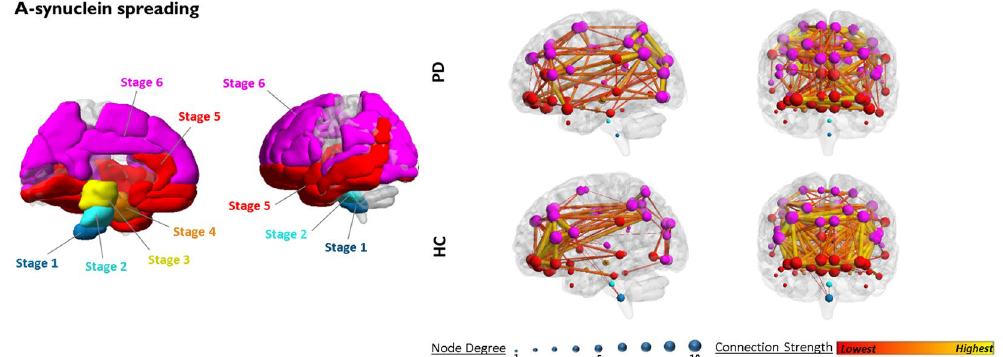
Figure 3. α -synuclein spreading analysis. Figure shows the progression of α -synuclein pathology according to Braak’s staging model (left panel). Metabolic connectivity alterations first appear in the lower brainstem, pons and midbrain (Braak’s stages 1, 2, 3) and furthermore spread to the orbitofrontal regions (stage 5). Connectivity between orbitofrontal (stage 5) and frontolateral cortex (stage 6) was also partly affected (right panel). The ROIs were defined according to AAL atlas (see text for details). α -synuclein-spreading connectivity results projected on a 3D brain template for PD and HC groups (right panel). Node degree, i.e. the number of connections for each region, is represented by the size of each dot. Connection strength is represented by the colour and thickness of each line connecting two